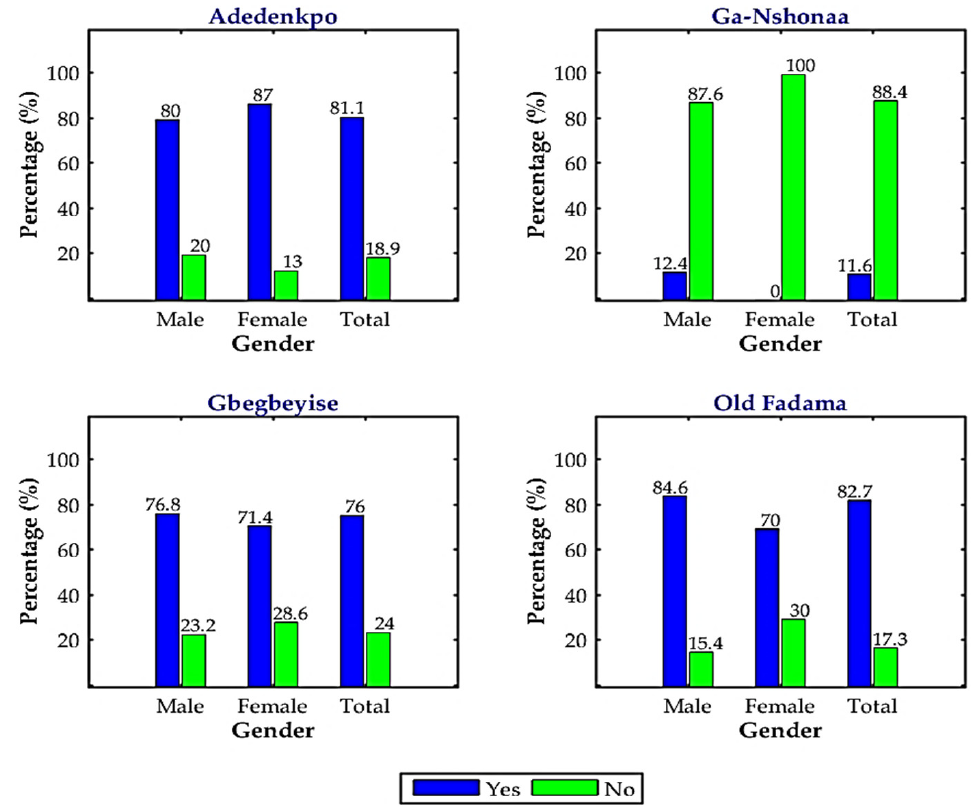
Figure 5. Sources of Early Warning from External Sources Over Last 1 to 2 Years According to Gender. Source: Authors’ construct, based on household survey.